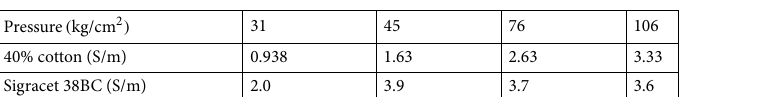
Pressure ( kg/cm 2